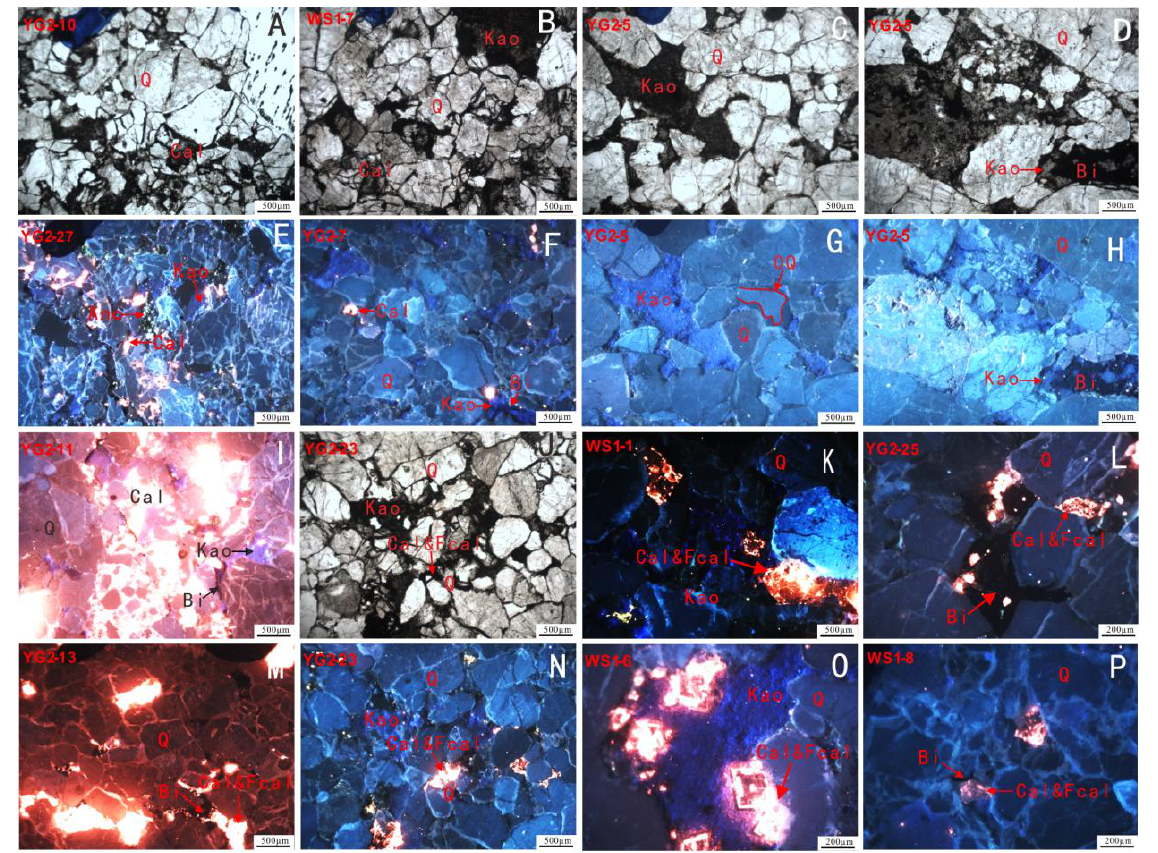
Figure 5. Photomicrographs showing the types and textures of minerals and bitumen under mono-polarized and cathodolu- minescent light. Mono-polarization photograph ( A ) of the YG2 well at 4703.79 m, ( B ) of the WS1 well at 4859.48 m, ( C ) of the YG2 well at 4701.63 m, ( D ) of the YG2 well at 4701.65 m; cathodoluminescence photograph ( E ) of the YG2 well at 4702.2 m; ( F ) of the YG2 well at 4702.6 m, ( G ) of the YG2 well at 4701.63 m, ( H ) of the YG2 well at 4701.65 m, ( I ) of the YG2 well at 4704.17 m; ( J ) mono-polarization photograph of the YG2 well at 4708.8 m; cathodoluminescence photograph ( K ) of the WS1 well at 4857.7 m; ( L ) of the YG2 well at 4709.5 m, ( M ) of the YG2 well at 4705.26 m, ( N ) of the YG2 well at 4708.8 m, ( O ) of the WS1 well at 4859.35 m, ( P ) of the WS1 well at 4859.7 m.